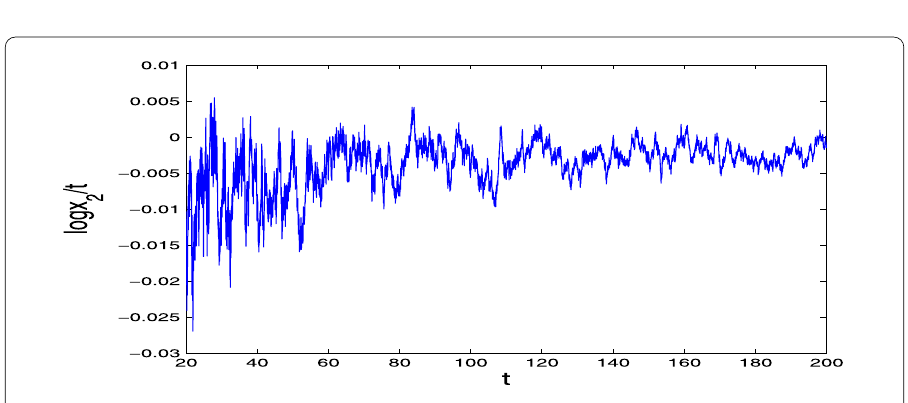
for system (61) with σ 1 (1) = σ 1 (2) = 2, σ 2 (1) = σ 2 (2) = 1.8. t